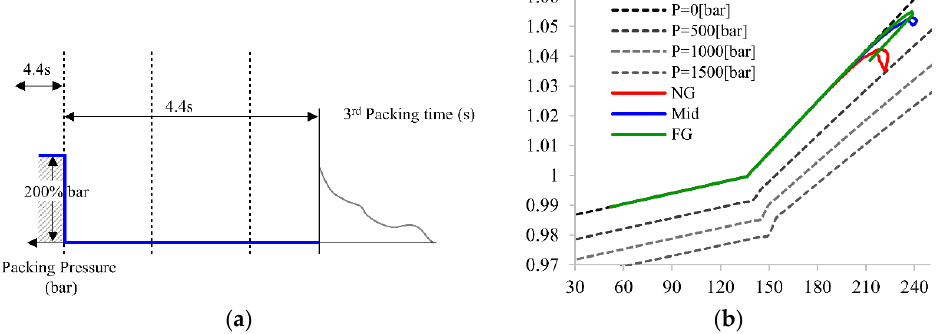
Figure 9. ( a ) Principle of intermittent packing pressure setup and ( b ) PVT processing path of principle of intermittent packing pressure setup for the FG section.